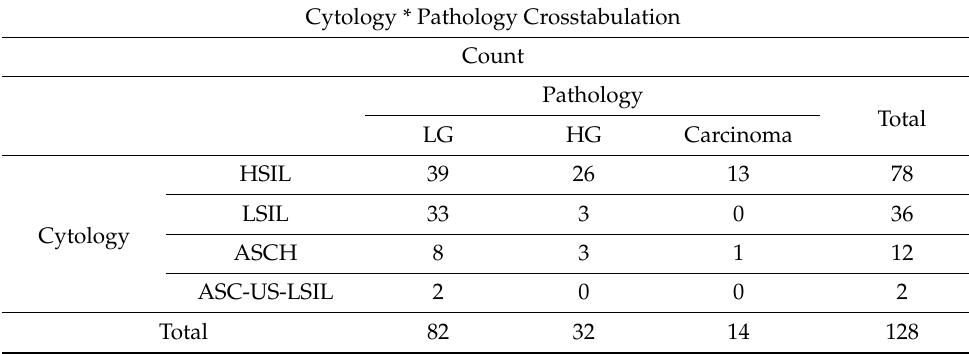
Table 3. Correspondence between cytology and